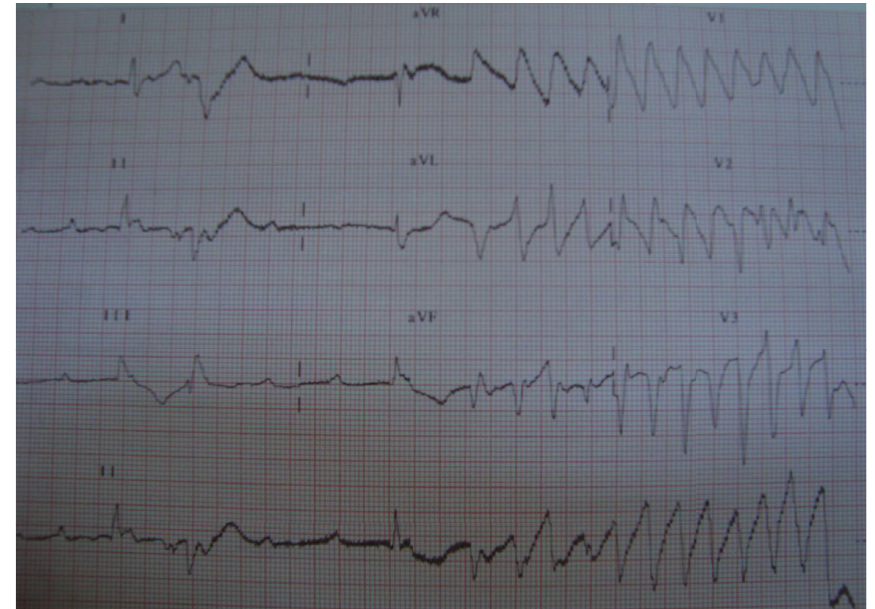
Figure 3: A TdP episode triggered by an early PVC which hit the descending portion of the T wave on ECG. ECG: electrocardiogram, TdP: torsade de